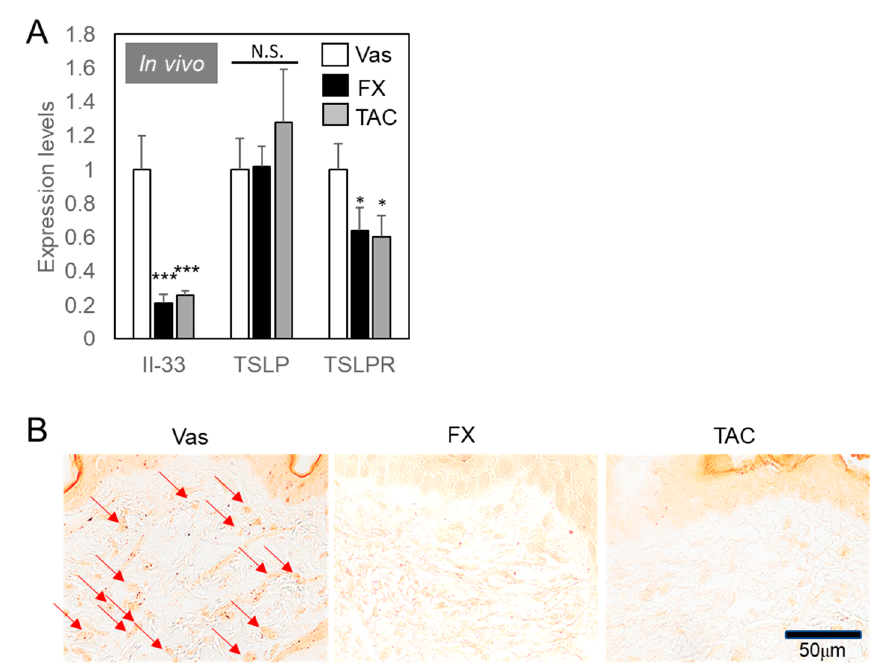
Figure 3 . Il-33-dependent eosinophil recruitments blocked by FX or TAC. ( A ) Keratinocyte-derived cytokines regulated by FX or TAC. Samples used in Figure 2C were analyzed using specific primer pairs. Values indicated means ± SEM from individual mouse averages ( n = 6) * p < 0.05, *** p < 0.005 compared with Vas control. N.S. = not significant. ( B ) Eosinophil recruitments were blocked by FX or TAC. Specimens were reacted with 0.5% congo red solution and washed. Arrows indicate congo red-positive eosinophils.